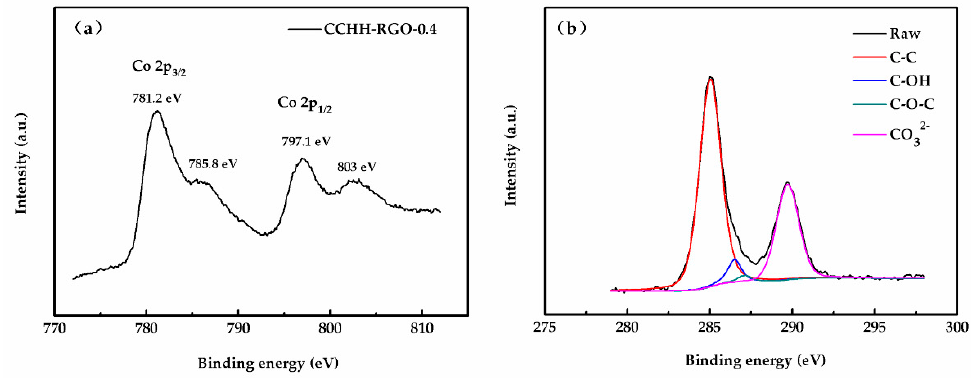
Figure 4. ( a ) XPS spectrum of the Co 2p composite; ( b ) XPS spectrum of the C 1s